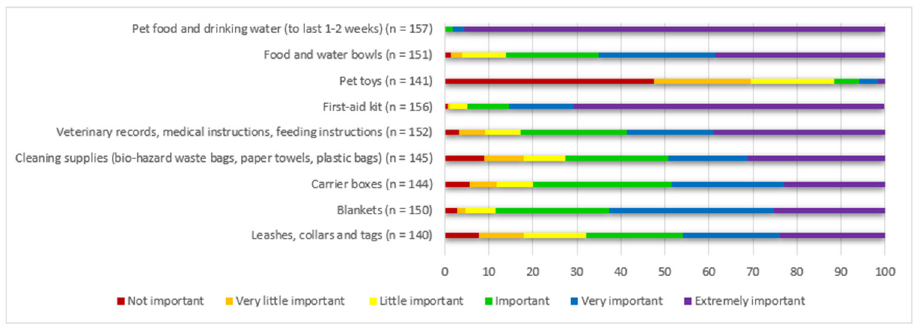
Figure 4. Level of importance attributed to items in pet disaster preparedness kits (number of respondents = 198).